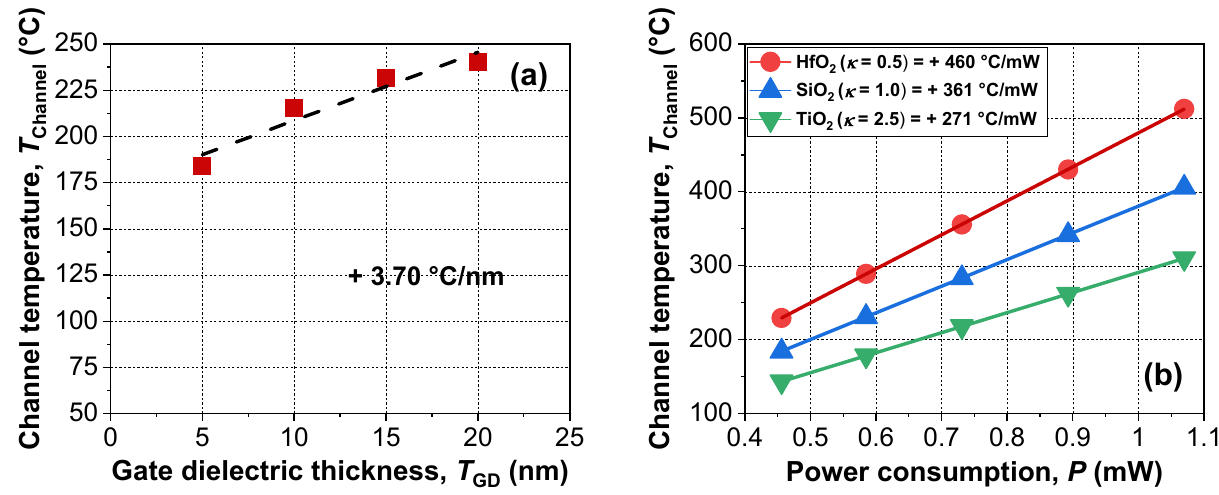
Figure 6. Extracted T Channel of devices with various ( a ) thicknesses and ( b ) materials of gate dielectric. Dashed lines indicate linear fits of the experimental data.